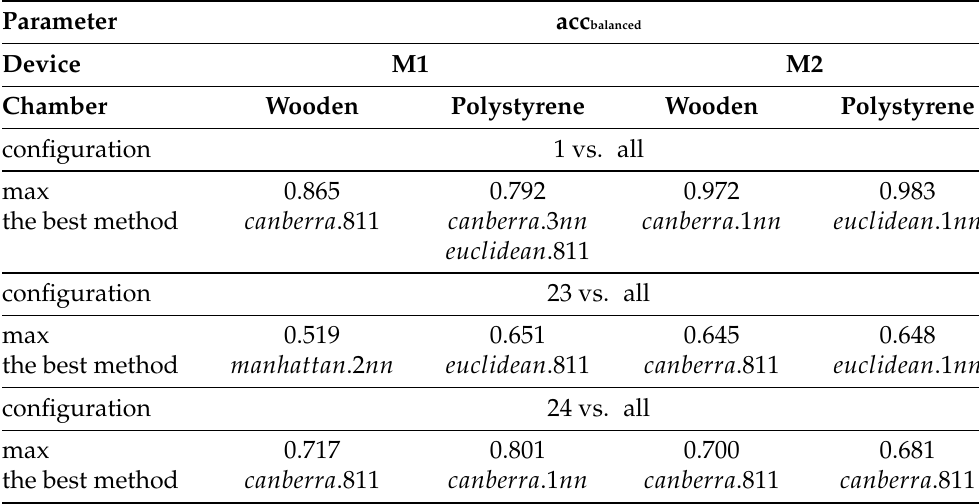
Table 6. Summary of the highest acc balanced values obtained in the 5 × MCCV-5 validation tests: specific class vs. other classes including classifiers that enabled obtaining these values (the best method) for devices M1 and